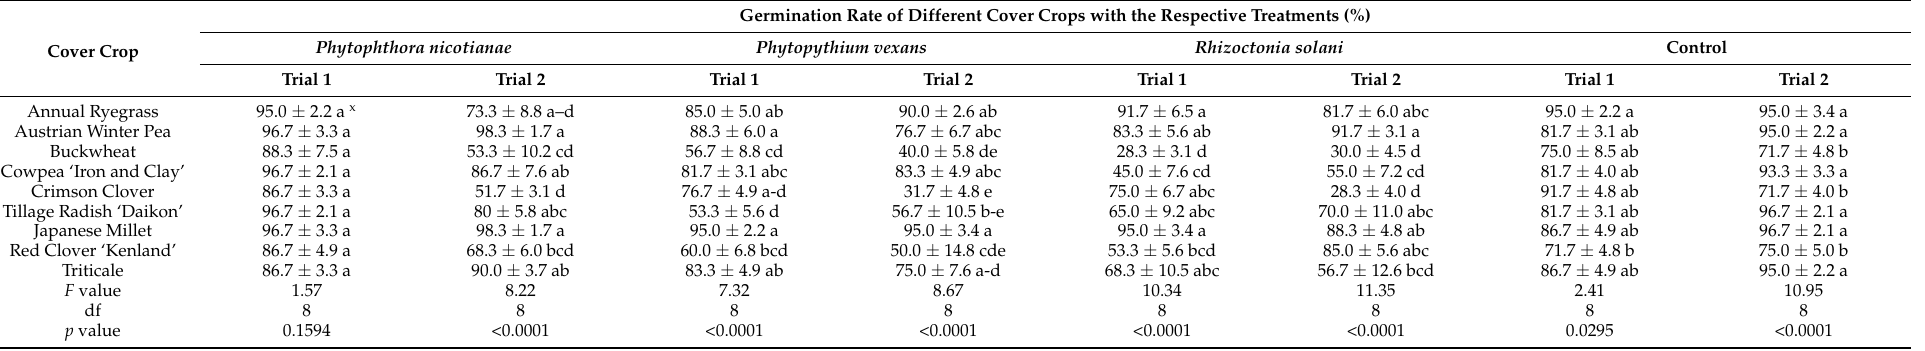
Table 5. Germination rate of different cover crops with the respective treatments of Phytophthora nicotianae , Phytopythium vexans , Rhizoctonia solani, and control.